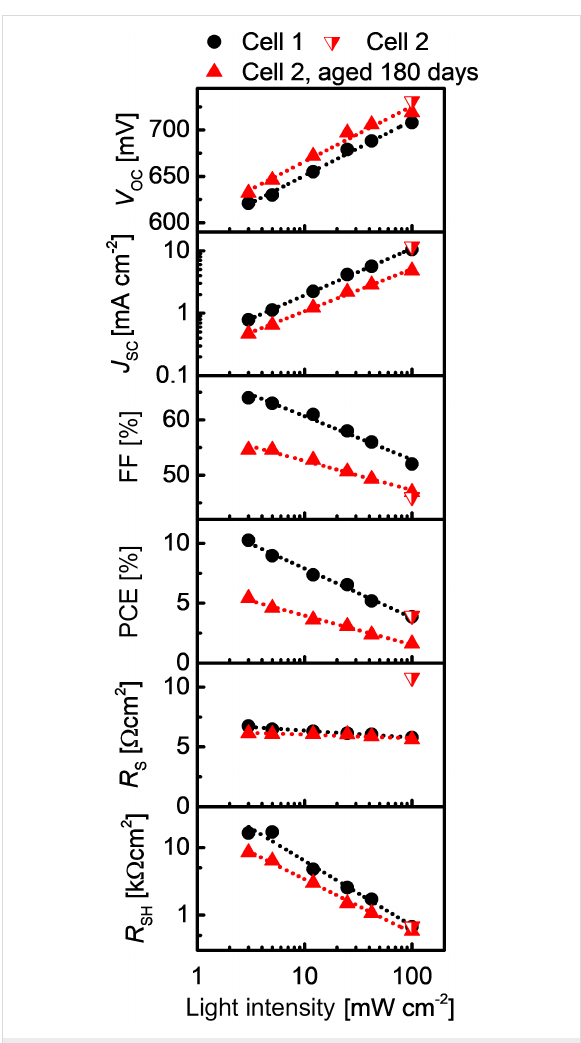
Figure 7: Photoconversion parameters of 100 nm Sb 2 S 3 solar cells without aging (black dots) or after 180 days of aging (red triangles) as a function of light intensity. The dotted lines are a guide to the eye. The light intensity was attenuated from AM1.5G, 100 mW cm − 2 with the use of metal mesh gray